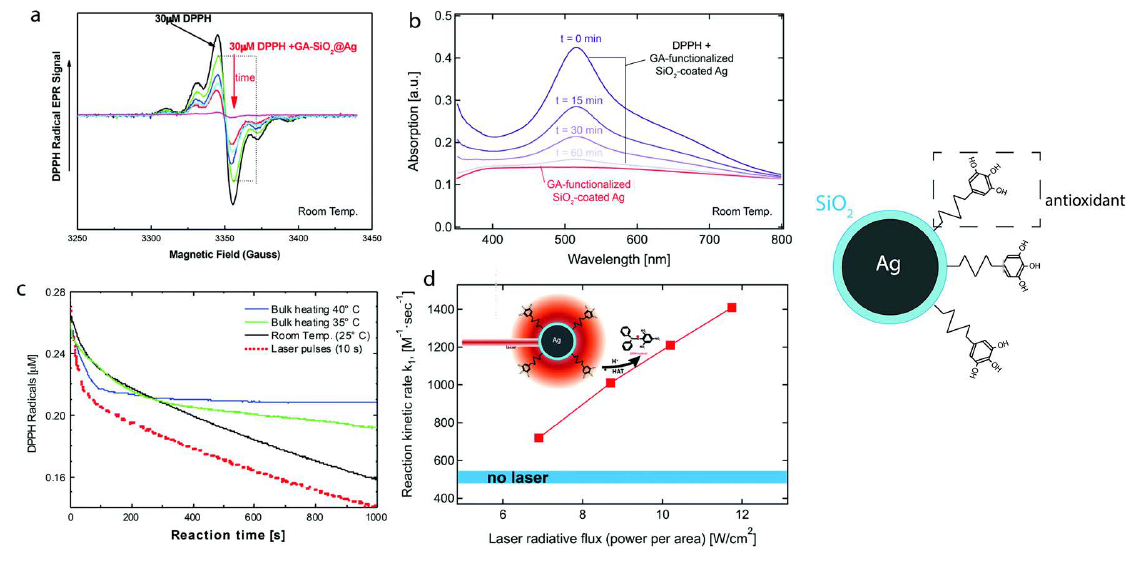
Figure 22. DPPH assay was used to evaluate the antioxidant activity of plasmonic Ag NPs grafted with gallic acid. Kinetic studies indicate a rapid phase at the beginning that determines the RSC towards DPPH • radicals [166]. During the fast phase, the SiO 2 @Ag@GA scavenges the DPPH • radical due to the 2-electron/2-proton reactions per GA molecule. After the grafting, the bond dissociation enthalpy of the GA-OH bond decreases by 2 kcal/mol. ( a ) and ( b ), EPR and UV–Vis spectra of SiO 2 @Ag@GA, ( c ) and ( d ) DPPH decay kinetics. Reprinted (adapted) with permission from [166]. Copyright 2023 American Chemical